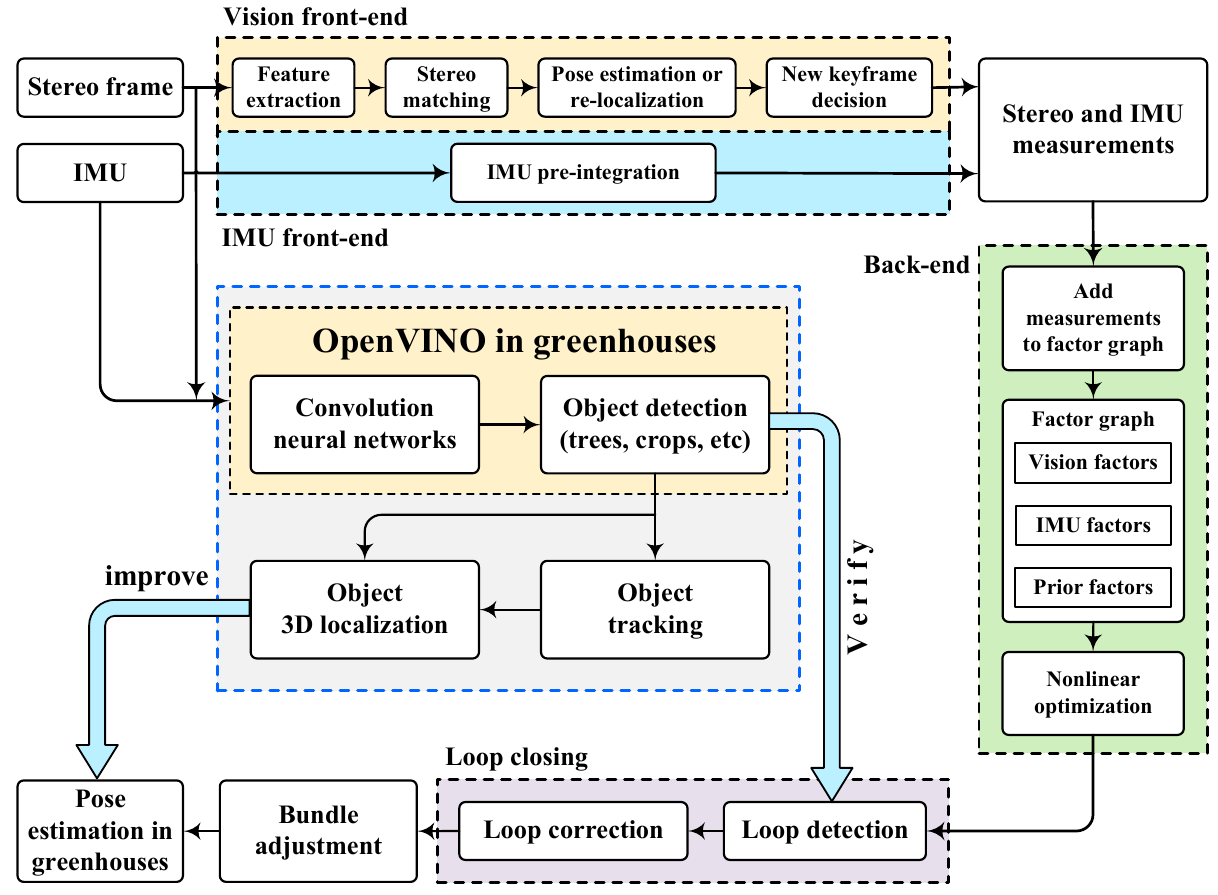
Figure 3. The pose estimation schematic diagram of the Intel RealSense tracking camera T265.